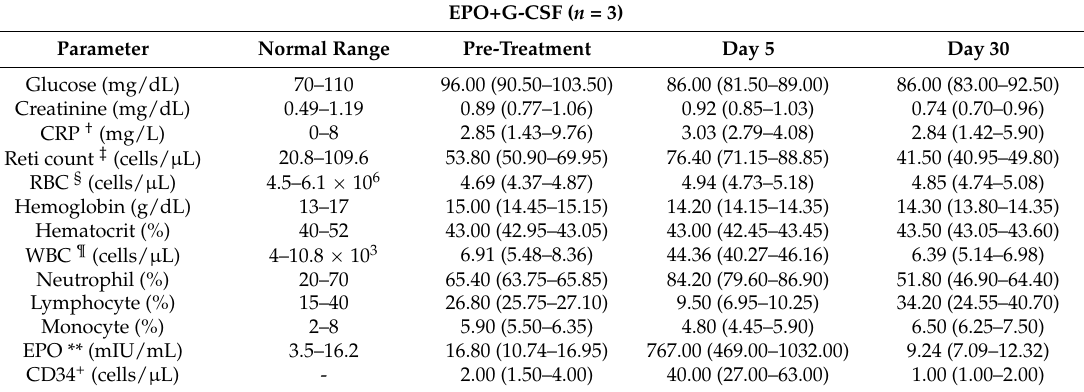
Table 2. Hematological parameters of the EPO and G-CSF combination therapy in stroke patients in a pilot study.